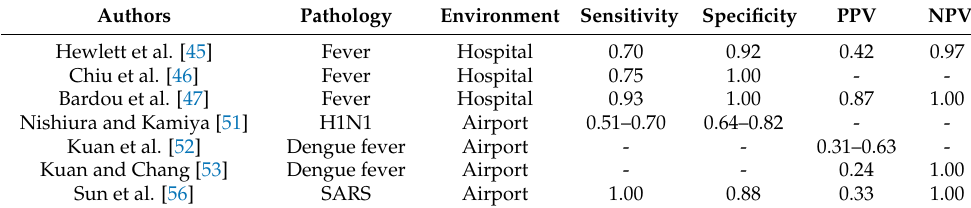
Table 1. Performances of IRI-based mass screening in